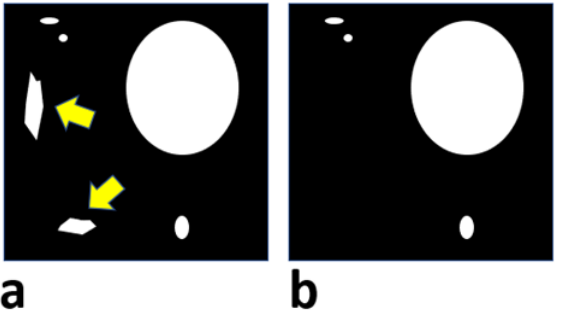
Figure 5. Schematic that shows elimination of the irregular shaped regions by using circularity as a threshold where, the irregular shaped artifacts as seen in ( a ) (indicated by arrows) are removed which results in the inclusion with only minor artifacts as seen in ( b ).